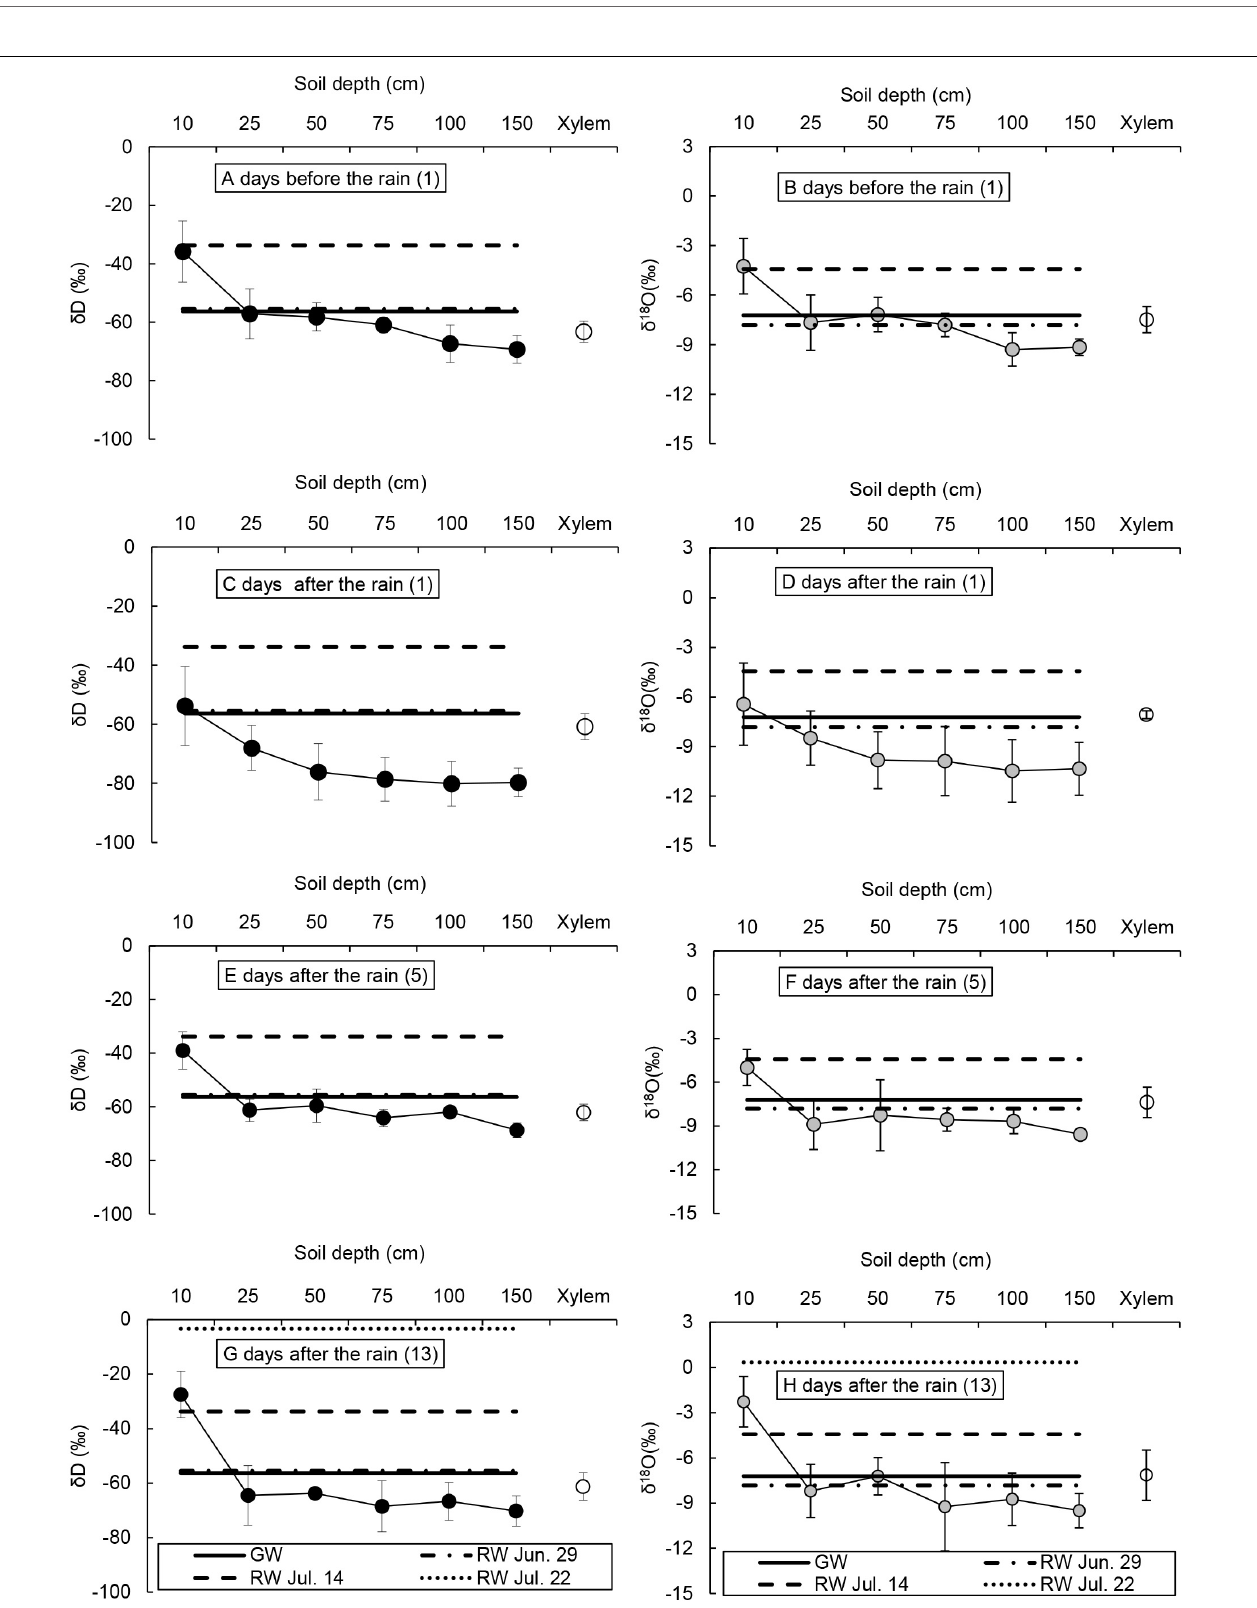
FIGURE 3 | The δ D (A,C,E,G) and δ 18 O (B,D,F,H) of xylem water and soil water of the Caragana intermedia community, rainwater (RW), and groundwater (GW) in the summer of 2016.